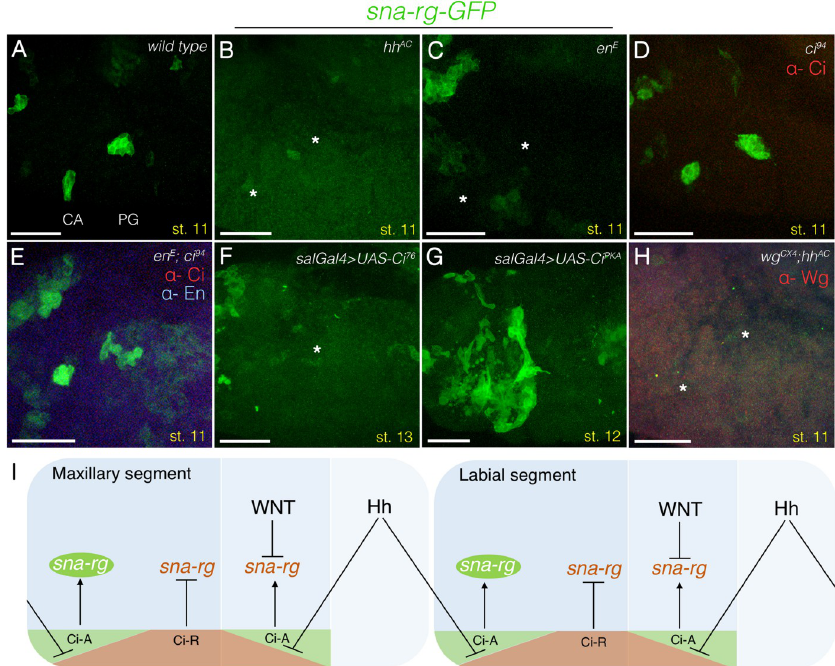
Fig 3. Hh pathway requirement for gland specification. (A-H) Embryos of various genotypes labelled with sna-rg- GFP (green) to mark the gland primordia. (A) Wild type embryo labelling the CA and PG location. (B) hh AC null and (C) en E null embryos show almost complete downregulation of the sna-rg enhancer (asterisks). (D) ci 94 null embryos show normal sna-rg activation. (E) Double en E , ci 94 mutants recover sna-rg expression in the CA and PG primordia. (F) Overexpression of the Ci repressor isoform with spalt-Gal4 downregulates sna-rg expression (asterisk marks the approximate position where stage 13 migrating primordia should be expected). (G) Overexpression of the Ci activator isoform with sal-Gal4 results in an expansion of sna-rg expression. (H) Double wg CX4 , hh AC mutant embryos lack sna- rg expression (asterisks). (I) Model summarising regulatory interactions between the Wnt and Hh pathways and the sna-rg enhancer (The interactions represented are not assumed to be direct). Panels D-E were also stained with anti-Ci, panel E with anti-En and panel H with anti-Wg to identify the mutant embryos. All embryos are at st11 except F and G which are at st13 and st12. Scale bar 50 μ